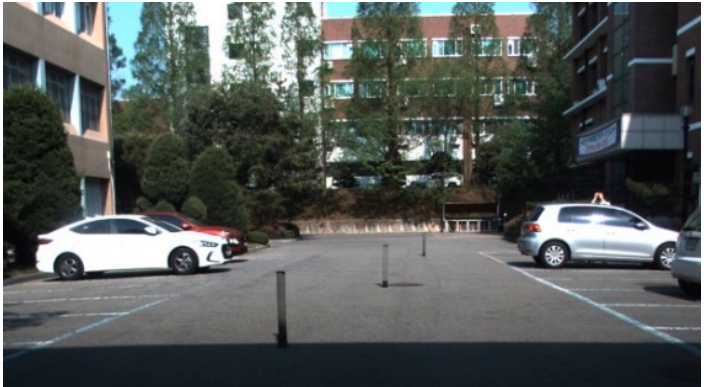
Figure 13. Test vehicle equipped with three lidars, one radar, and a dashboard camera. The measurements used a thin object to maintain the accuracy of the camera and radar’s projection transformation matrix. For these thin objects, the matrix was computed using the image’s x and y ground coordinates, and the radar detection results were projected onto the image coordinate system using the calculated matrix (Figure 14). Sensors 2020 , 20 , x FOR PEER REVIEW